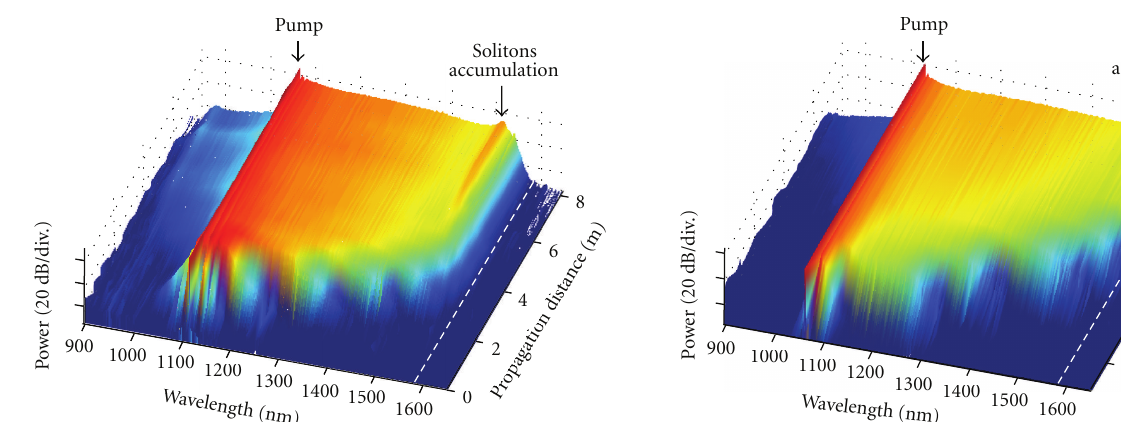
Figure 8: Experimental dynamics of the SC formation as a function of fiber length in the solid-core PBG fiber 2 for a pump power of 2.3kW. The white dashed line represents the PBG edge.